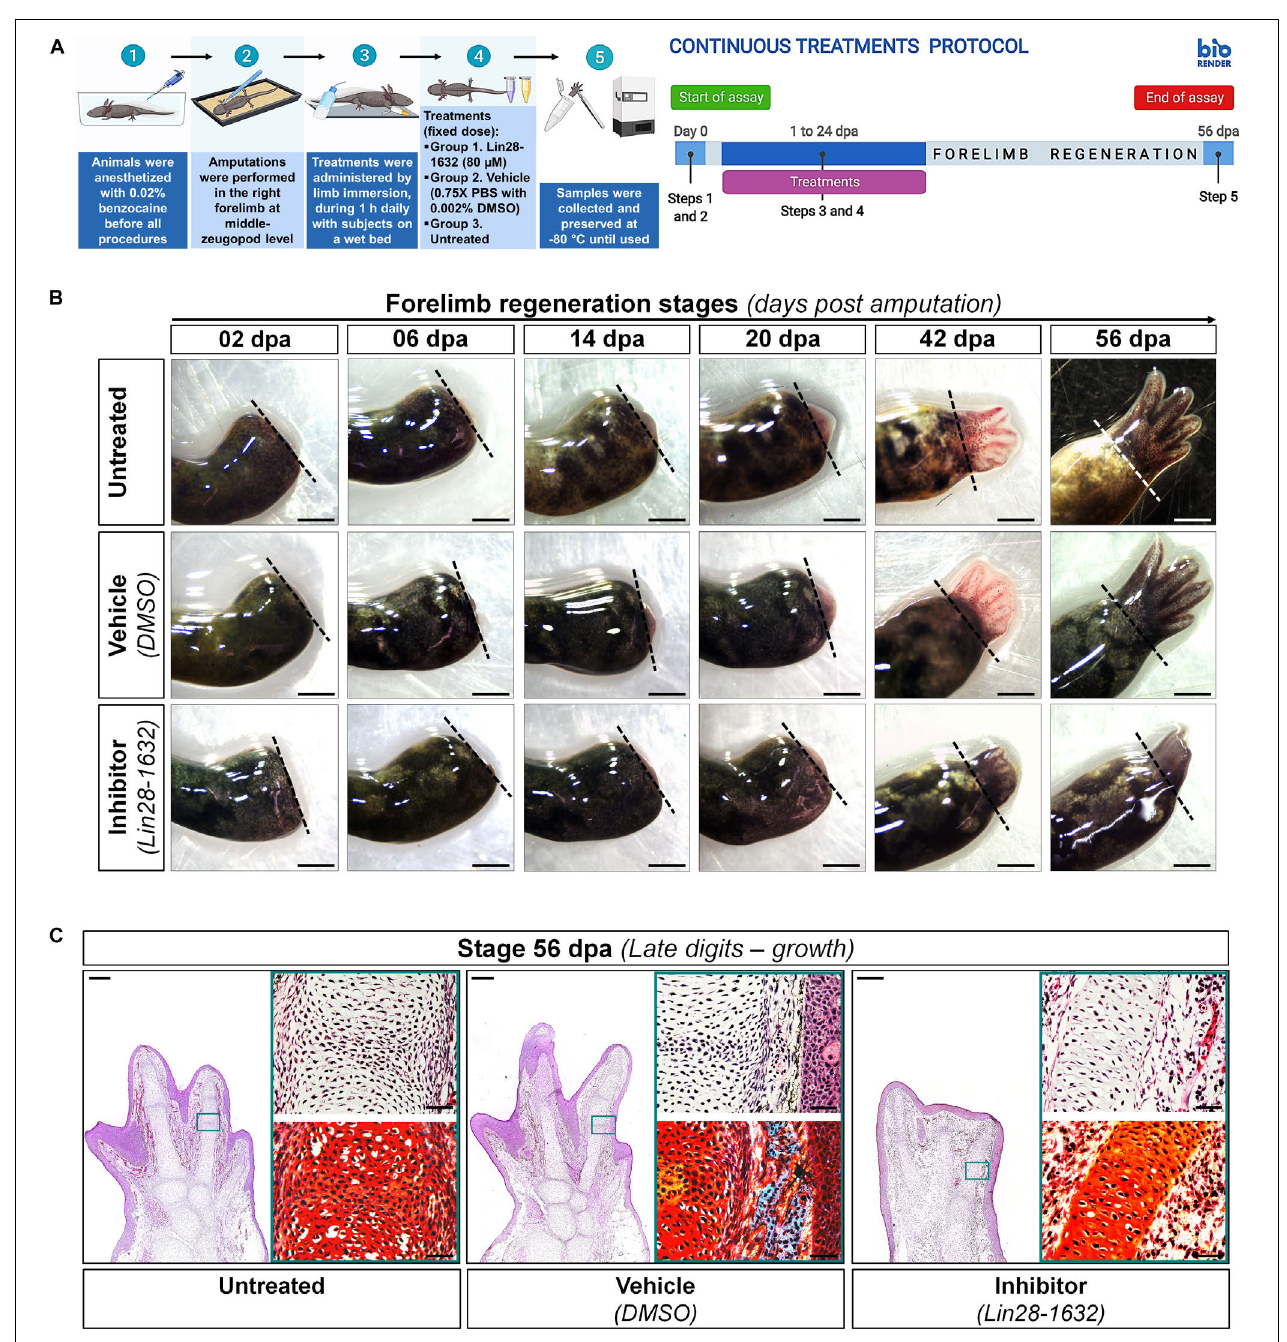
FIGURE 9 | Phenotypic effects induced after long-term functional inhibition of Lin28 during limb regeneration. (A) Schematic diagram describing the protocol of continuous treatments implemented; on the left side, the general strategy followed is shown, and on the right side, the temporary management schedule during limb regeneration process. Created with BioRender. (B) Morphological changes registered after application of distinct treatments assayed at the end of regeneration. Dotted lines indicate the amputation site. Scale bars: 1 mm. (C) Histological sections at 56 dpa to analyze changes in the architecture and organization of tissues through H&E staining, after diverse treatments applied. The upper right panel displays a close-up of a representative region, and the lower right panel a similar region with a differential staining for connective tissue. Scale bars: 500 and 50 µ m, respectively.